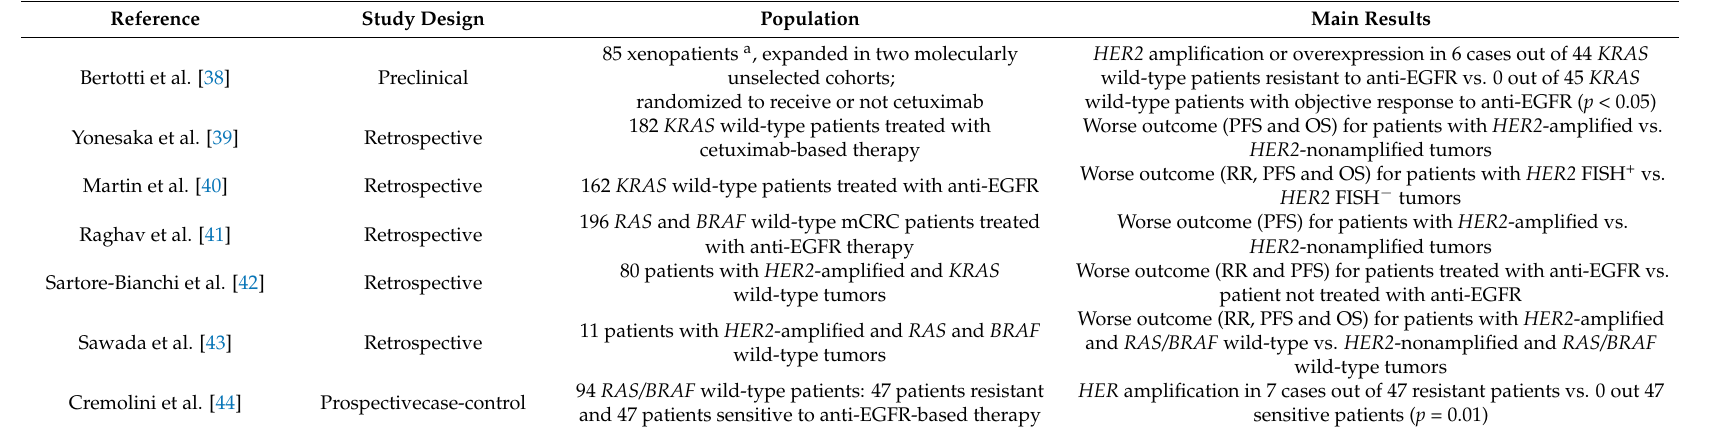
Table 1. Studies investigating HER 2 amplification as a predictor of resistance to anti-EGFR